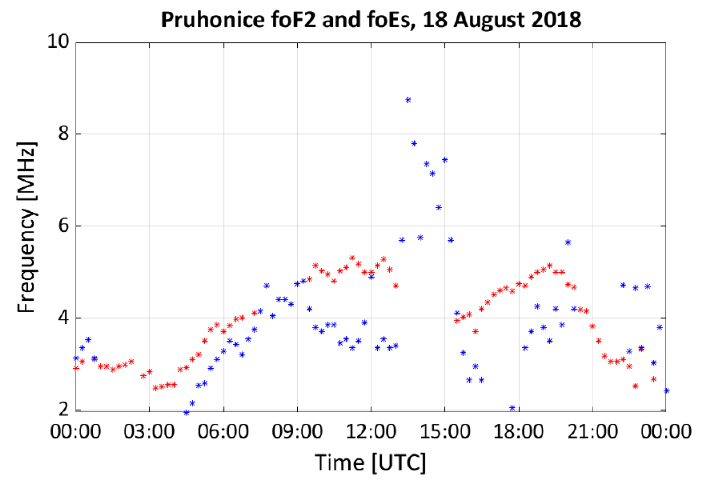
Figure 7. Autoscaled f o F2 (red) and f o Es (blue) from the Pruhonice ionosonde for 18 August 2018.